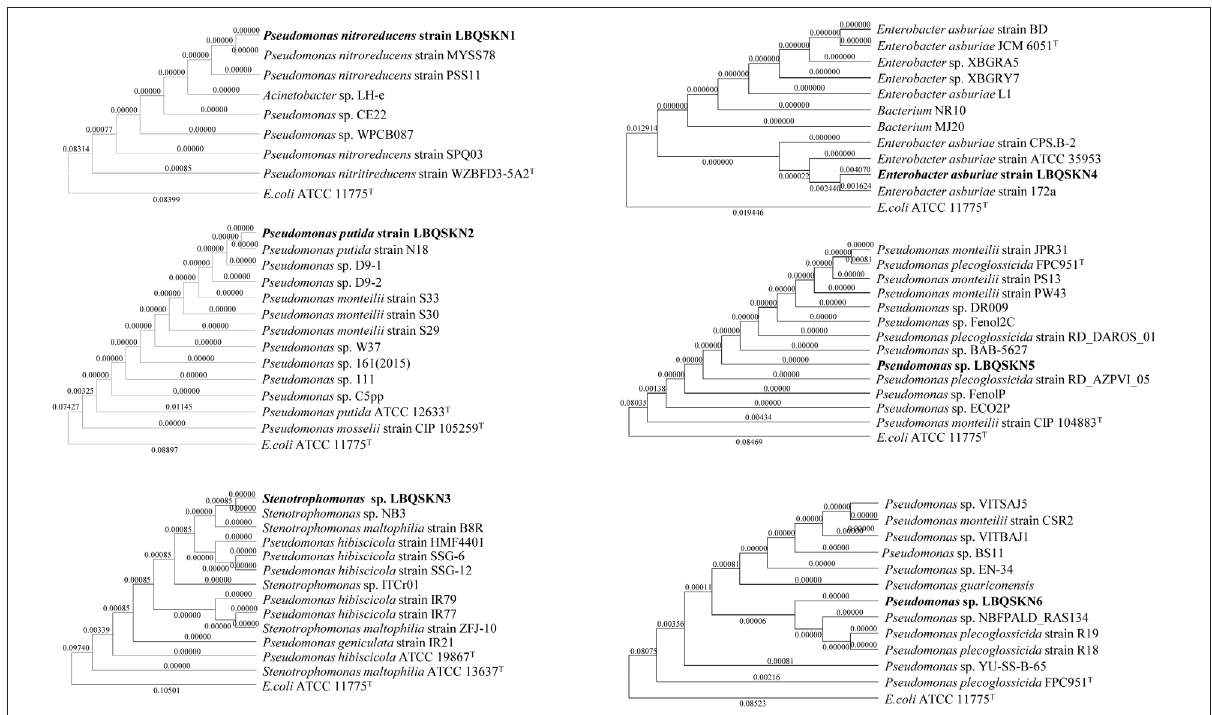
Figure 3: Phylogenetic analysis of the 16S rRNA gene sequences of the bacterial isolates. 16S rRNA gene sequences of the type strains belonging to the same genus and an out-group bacterial species ( E. coli ) were also included in the analysis. Superscript letter ‘T’ next to strain name indicates the type strain. Each bacterial isolate was named based on its alignment to the homolog bacterial species. Branch lengths are also shown in the tree. Bacterial species isolated and named in this study are highlighted in bold